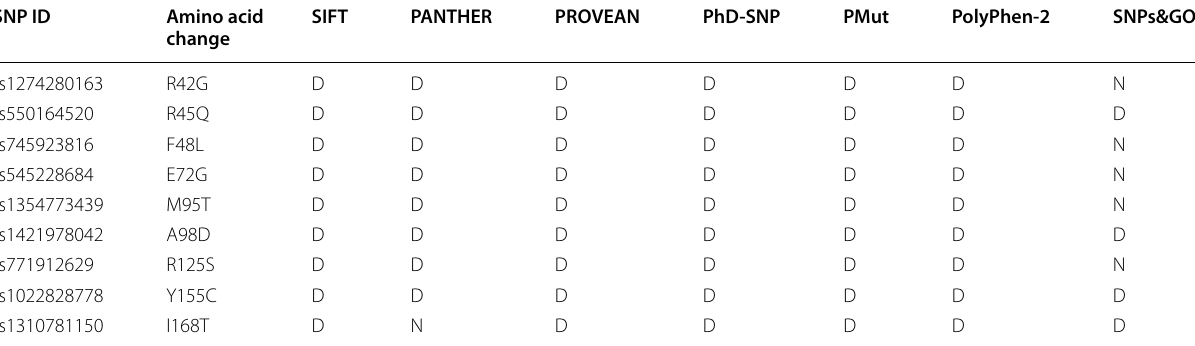
*Here, “D” indicates disease and “N” indicates neutral